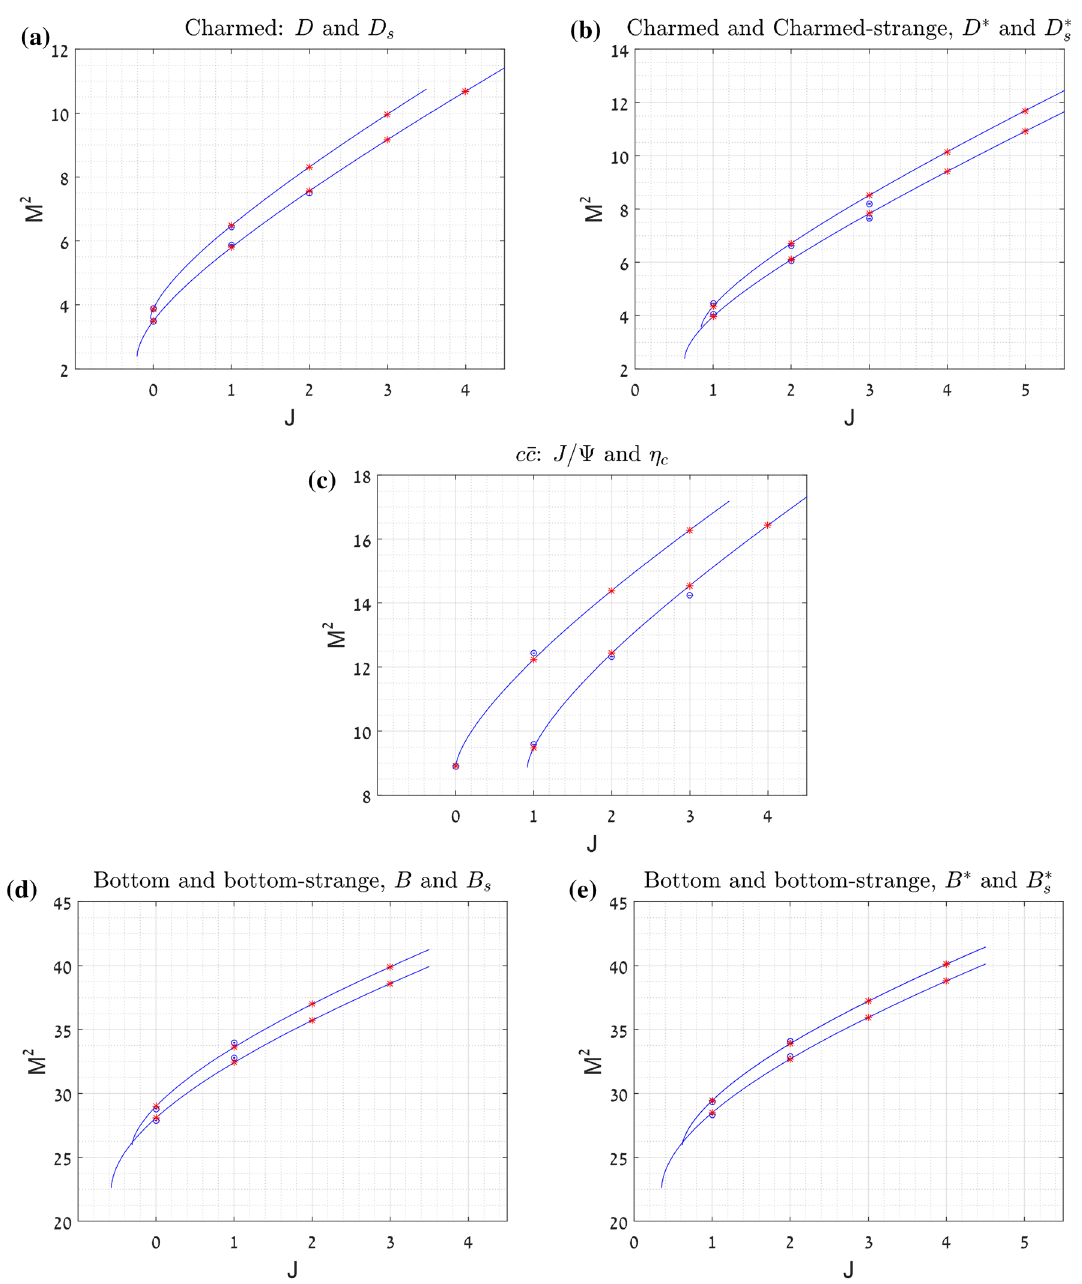
Fig. 4 The leading orbital modified Regge trajectories of heavy light mesons and charmonium, fitted with the common slope α (cid:2) = 0 . 88 GeV − 2 . All the states fitted are listed in the appendix in Table 14. In blue are the data points, and the red asterisks along the trajectory are the theoretical